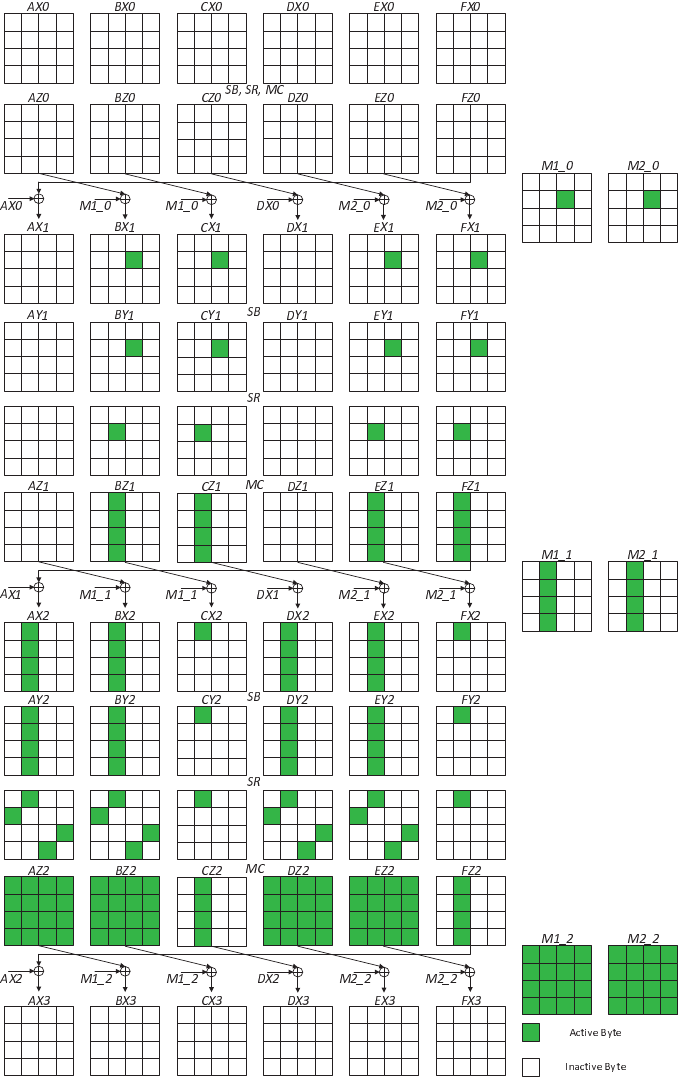
Figure 8: Invalid differential characteristic for